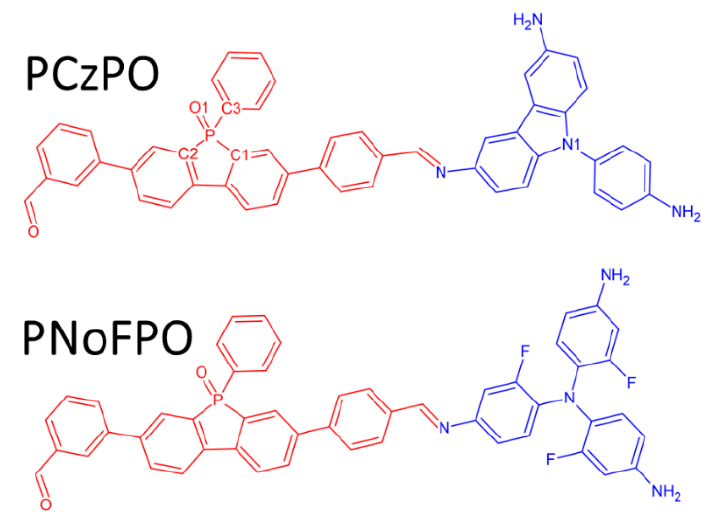
Figure 1. 2D molecular structures of poly[4,4 ′ -(9-(4-aminophenyl)-9H-carbazole-3,6-diamine- alt -5-oxido-5-phenylbenzo[b]phosphindole-3,7-diyl)dibenzaldehyde] (PCzPO) and poly[N 1 ,N 1 -bis(4-amino-2-fluorophenyl)-2-fluorobenzene-1,4-diamine- alt -5-oxido-5-phenylbenzo[b]phosphindole-3,7-diyl)dibenzaldehyde] (PNoFPO) donor-acceptor (D-A) moieties (donor group in blue and acceptor group in red).